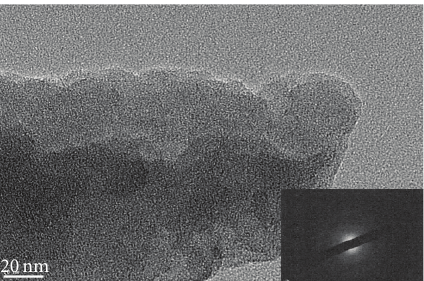
Figure 4: TEM image and SAED of char obtained from Japanese cedar wood meal pyrolyzed at 800 ∘ C.